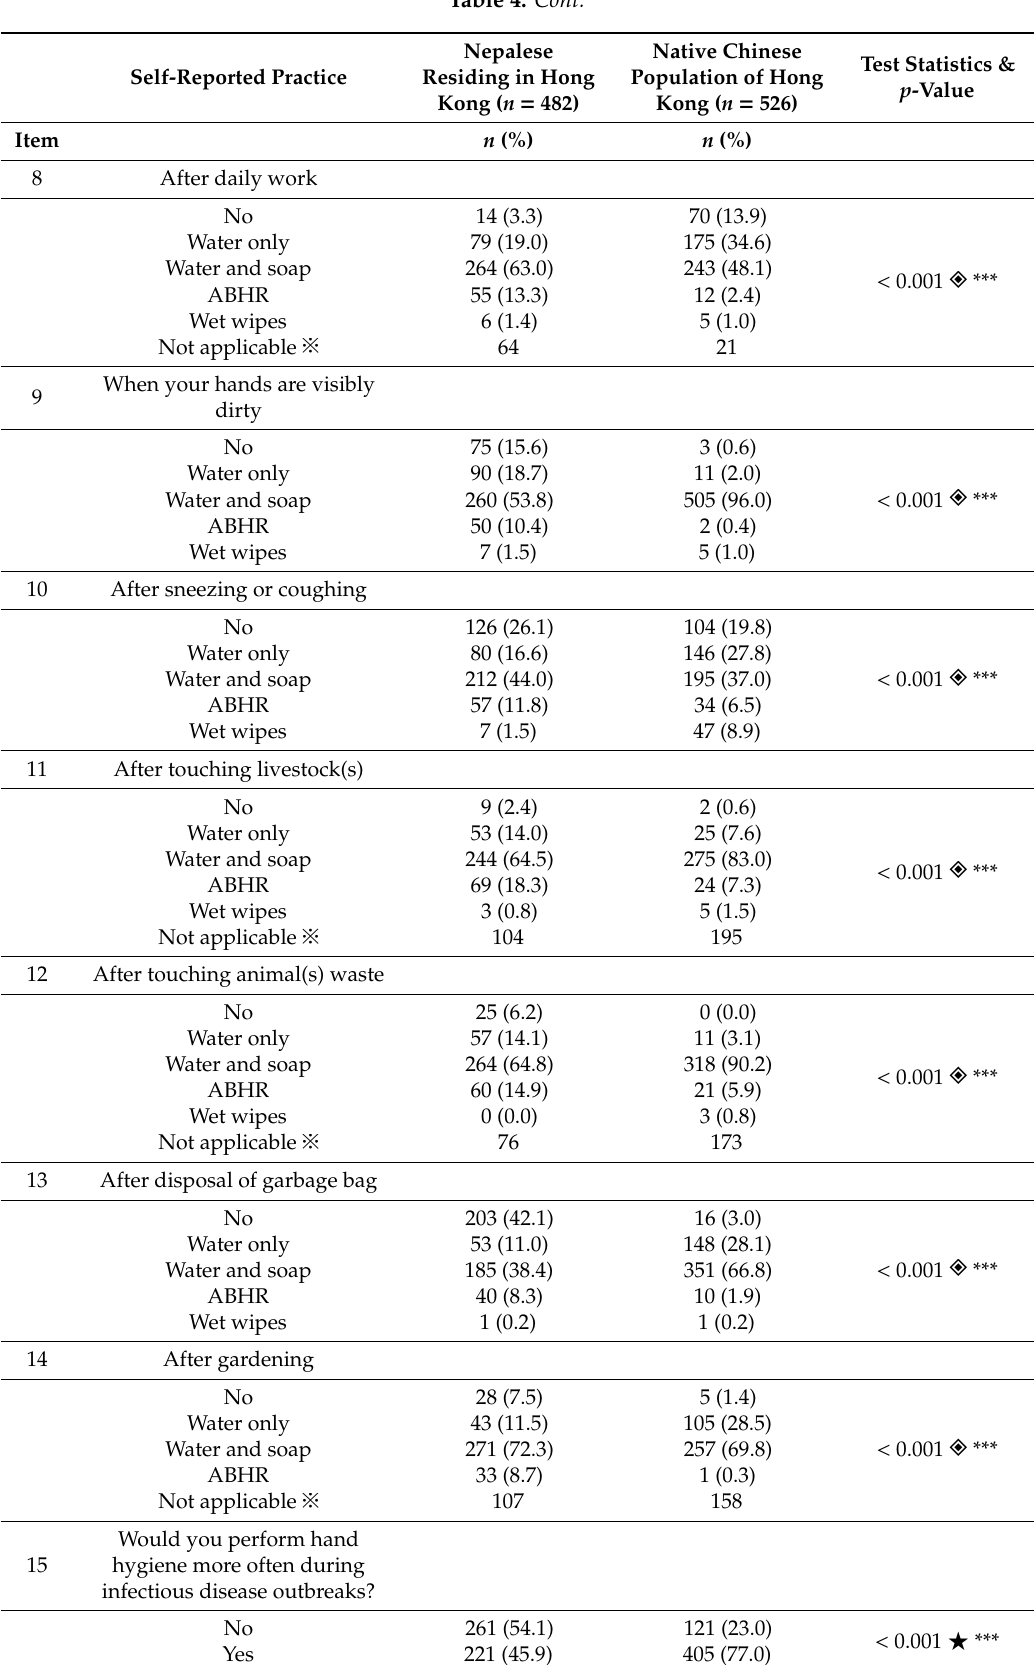
Table 2. Knowledge level on hand hygiene (0 to 12).